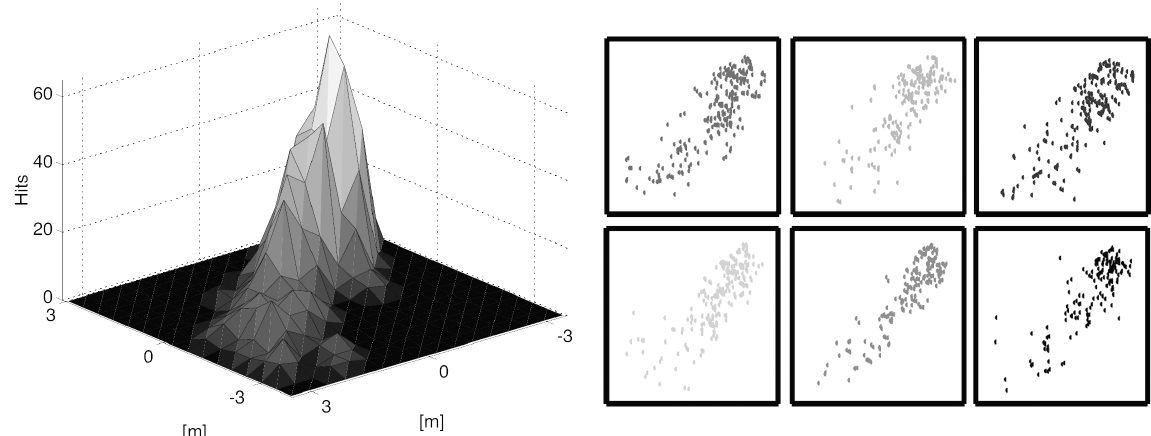
Figure 6 . Visualisation of the number of odour hits (i.e. how often the sensor response exceeded a pre- defined threshold) recorded by six robots while performing a random walk behaviour for one hour. The left figure shows a visualisation of the two-dimensional histogram which is obtained by accumulating the odour hits received by all the robots. The spatial distribution of odour hits received by the individual robots can be seen in the six sub-images on the right side. The source location corresponds to the upper right corner of these subimages. Adapted from Hayes et al.